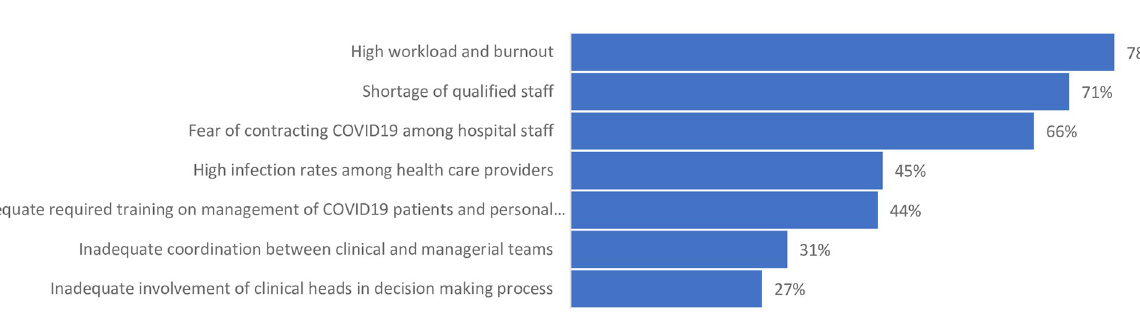
Fig 4. Challenges faced by hospitals in the EMR related to human resources (n = 139), July 2020.